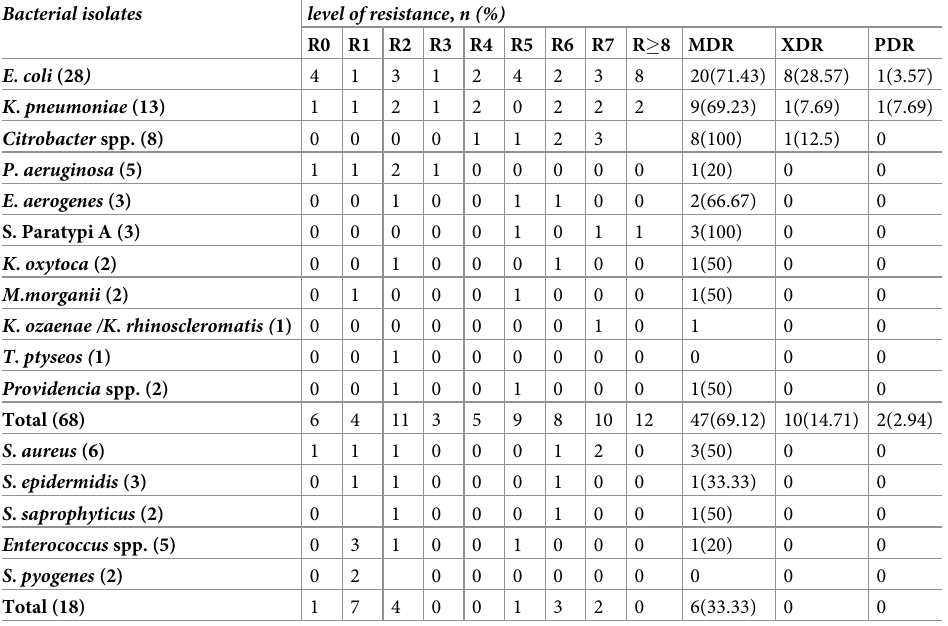
Table 7. Phenotypic resistance profile of bacteria isolated from the urine of under-five children at HFSUH, east- ern Ethiopia, 2021. Bacterial